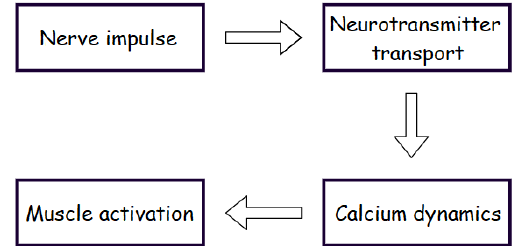
Fig. 1: General scheme of the process of neuromuscular